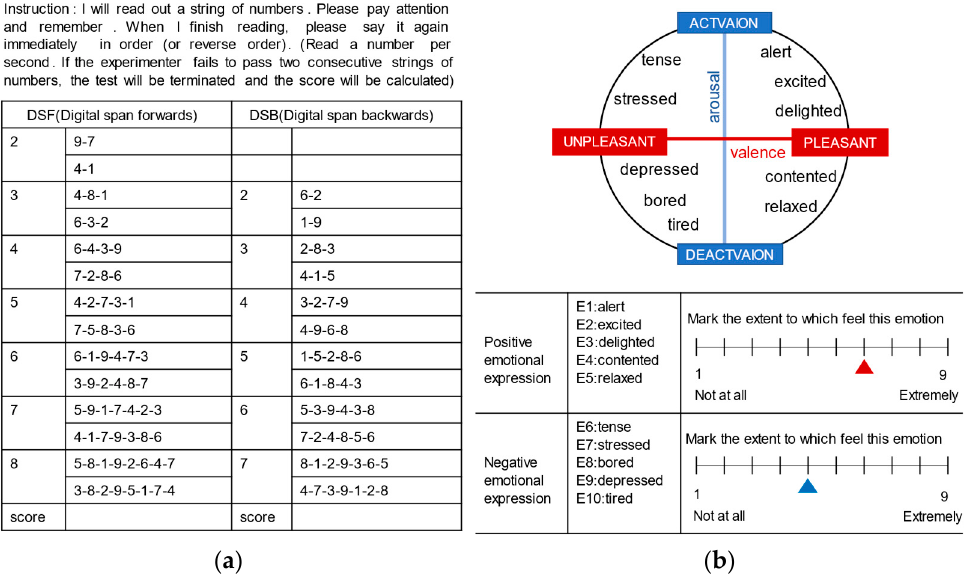
Figure 2. ( a ) Cognition test method; ( b ) Emotion measurement method.